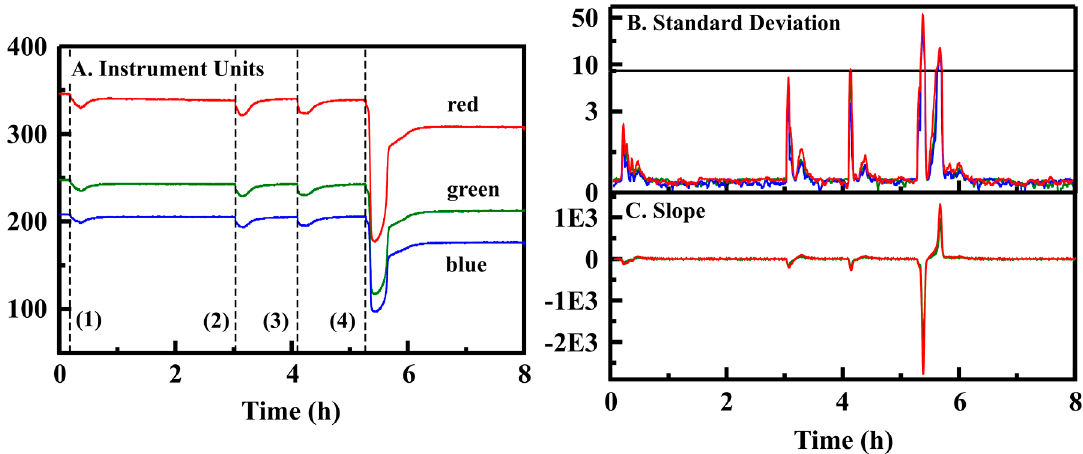
Figure 2. ( A ) PT3 data for a single indicator (RGB values, 5 s sampling interval) with multiple exposures (indicated by dashed lines) at maximum ethanol concentrations of 8 (1, 2 & 3) and 16 ppm (4); ( B ) Standard deviation over time calculated using a 12 point sliding window for presented data; ( C ) Slope over time calculated using a 50 point sliding window for presented data.